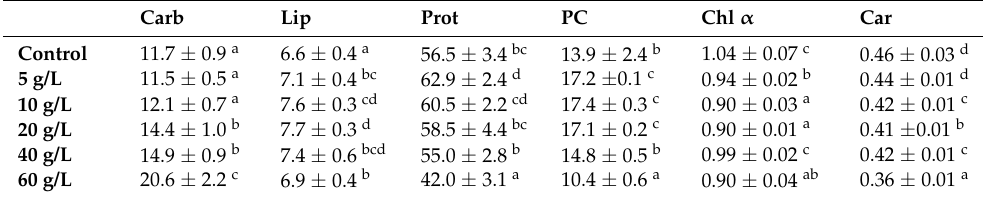
Table 1. Biomass composition of A. platensis grown at different salinities. (Carb: carbohydrates; Lip: lipids; Prot: proteins; PC: phycocyanin; Chl α : chlorophyll α ; Car: carotenoids; Phen: phenolics). Values are based on the organic matter (% OM) of biomass, excluding ash content ( n = 3, ± SD). The different superscript letters denote statistically significant differences. Carb Lip Prot PC Chl α